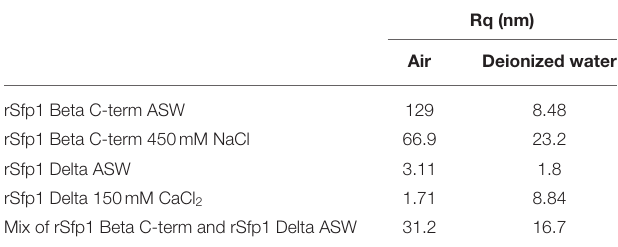
( Figure 3J ). As control, Bovine Serum Albumine prepared in Rq (nm)